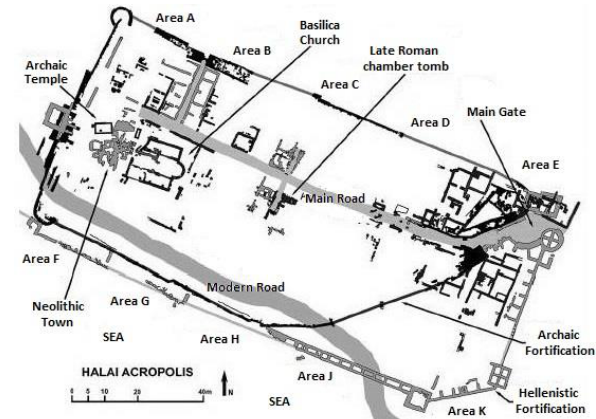
Figure 3. Plan of the excavation segments in Acropolis of Halai. The underwater fortification is situated in Area G © J. Coleman